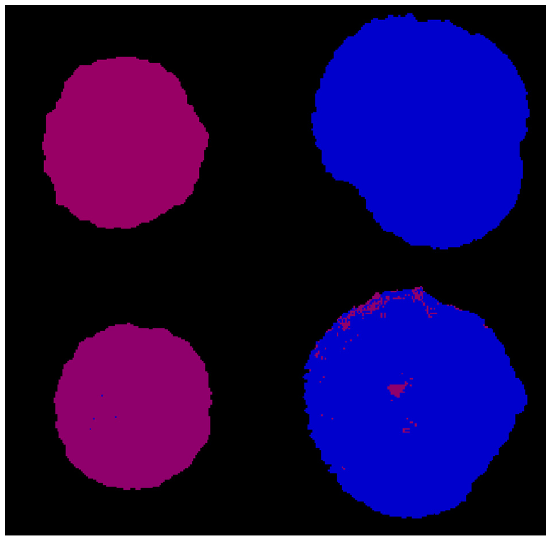
Fig. 9. Prediction image for colonies on di®erent media (Classi¯cation based on the training data is in the upper row, and the bottom row is the classi¯cation result of the indepen- dent validation